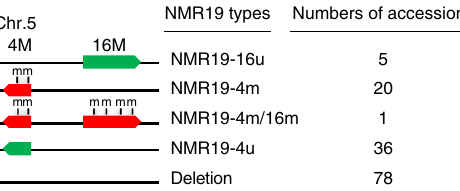
(Fig. 4b). The DNA methylation patterns of NMR19-4 of F2 WT individuals were maintained in the F3 generation (Fig. 4c;